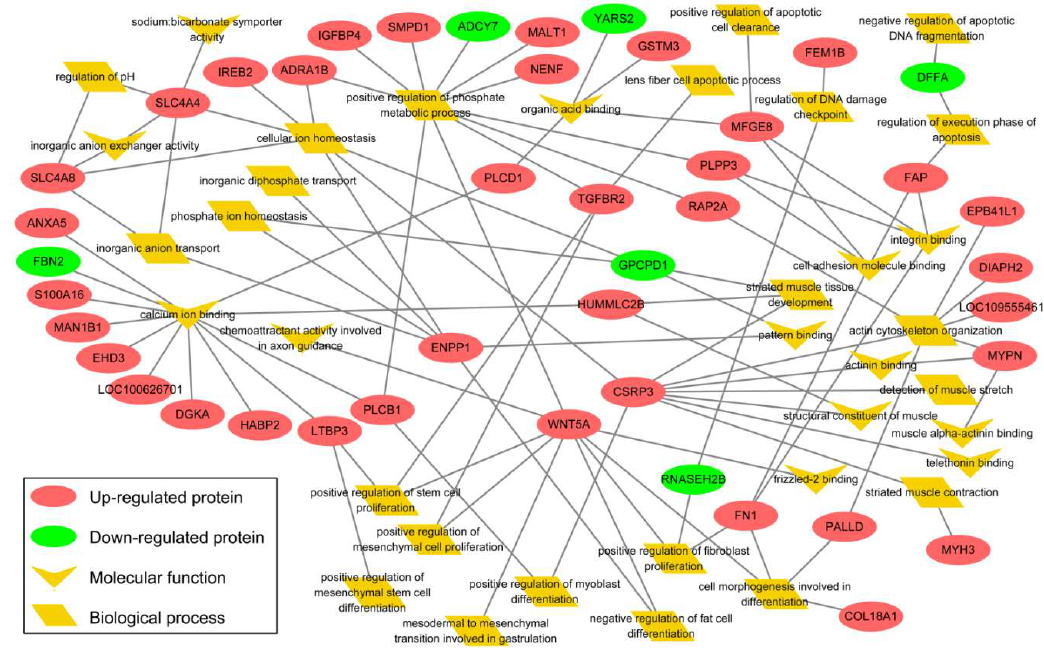
Figure 5. Interaction of differentially expressed proteins of Myo-lineage cells between obese- and lean-type pigs involved in muscle development, ion homeostasis, cell proliferation and differentiation, and apoptosis. The yellow nodes represent one of the molecular functions or biological processes enriched with differentially expressed proteins by GO analysis. The red and green circles mean proteins up- and downregulated in Myo-Y relative to Myo-L, respectively. Networks were drawn and visualized by Cytoscape (v3.2.1). Myo-L and Myo-Y represent Myo-lineage cells derived from skeletal muscle of obese- and lean-type pigs, respectively.